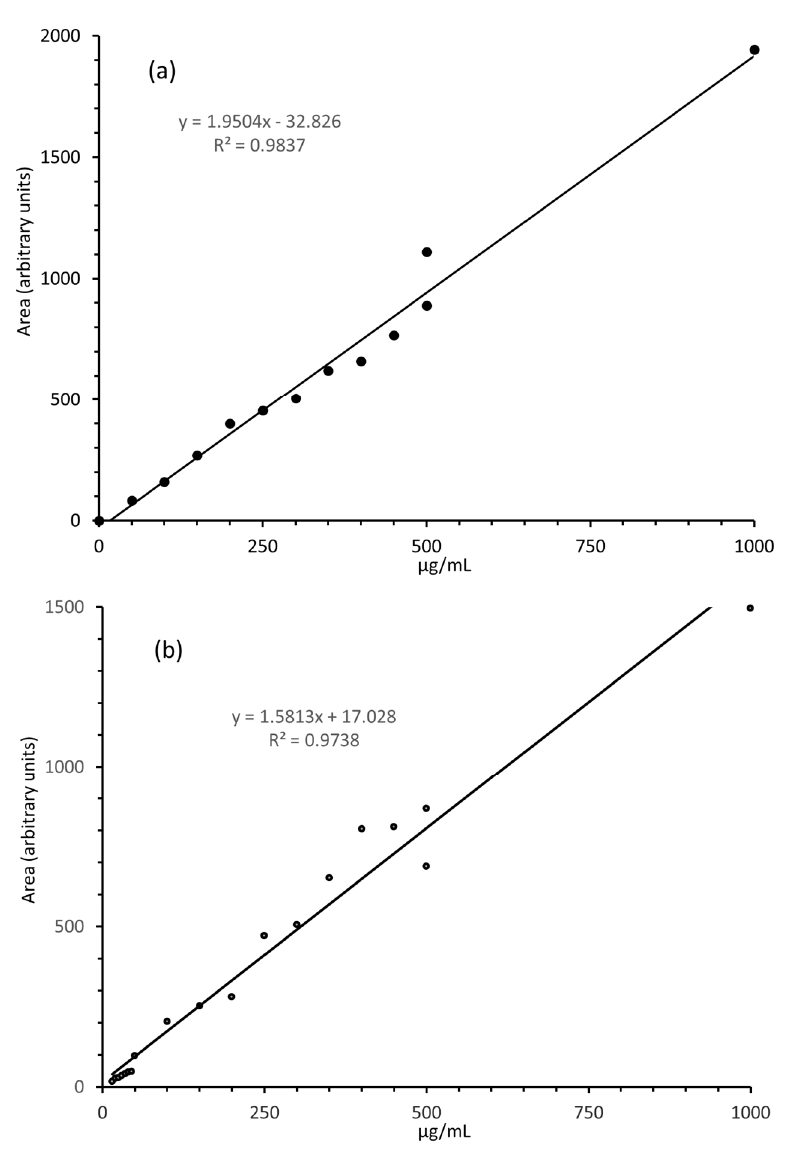
Figure 4. Calibration curves for 8- O -methylbostrycoidin ( a ) solvent and ( b ) matrix standards.